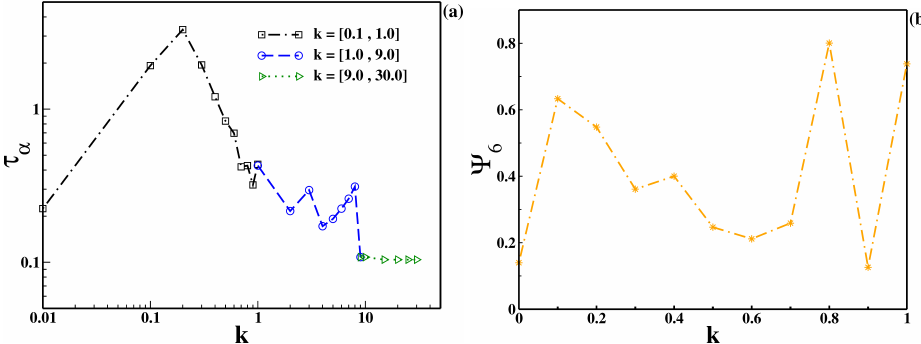
Figure 10. ( a ) Structural relaxation time and ( b ) global orientational order parameter as a function of the stiffness parameter, k